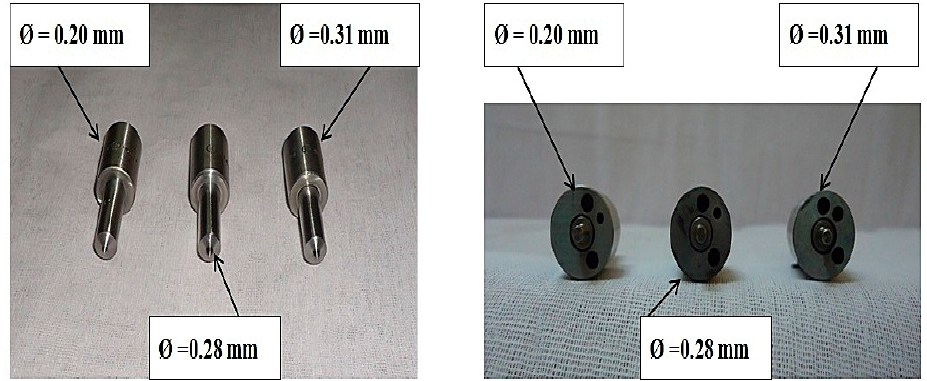
Figure 5. Nozzles of different sizes.